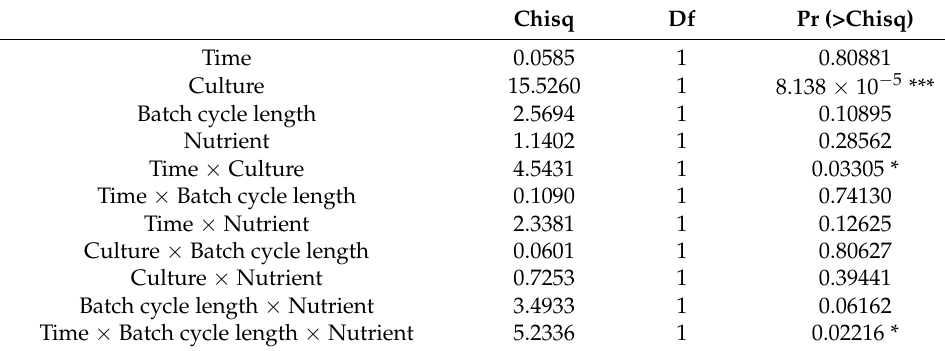
Table 4. Analysis of deviance table of Type II Wald χ 2 tests for generalized linear mixed-effects model using the proportion of E. huxleyi genotype C41 as response variable. Stars show significance level of the test; *** p < 0.001 and * p <